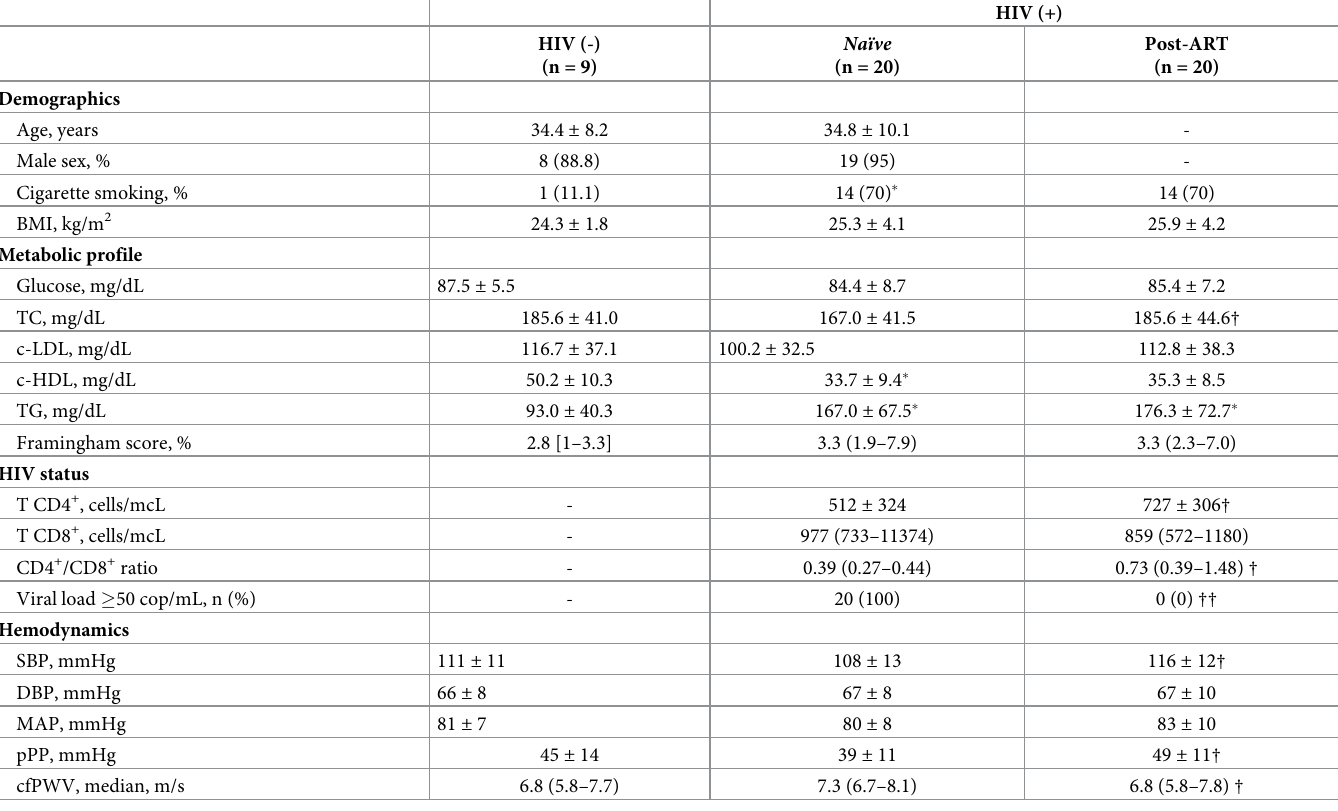
Table 1. Demographic, metabolic, HIV and vascular data from HIV negative and treatment- naïve HIV individuals at baseline and 1-year post ART follow-up